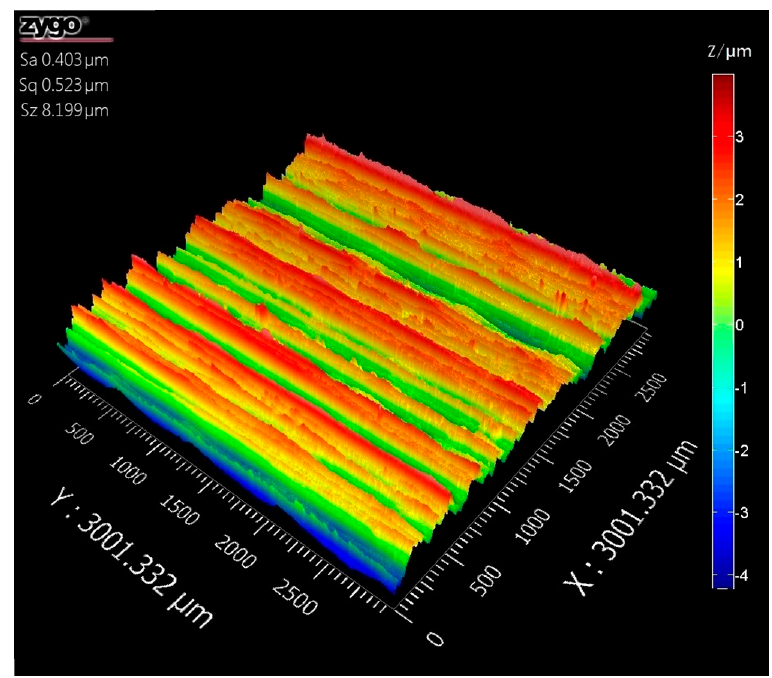
Figure 4. Measured topography of grinding surface under Sa 0.403 μ m.